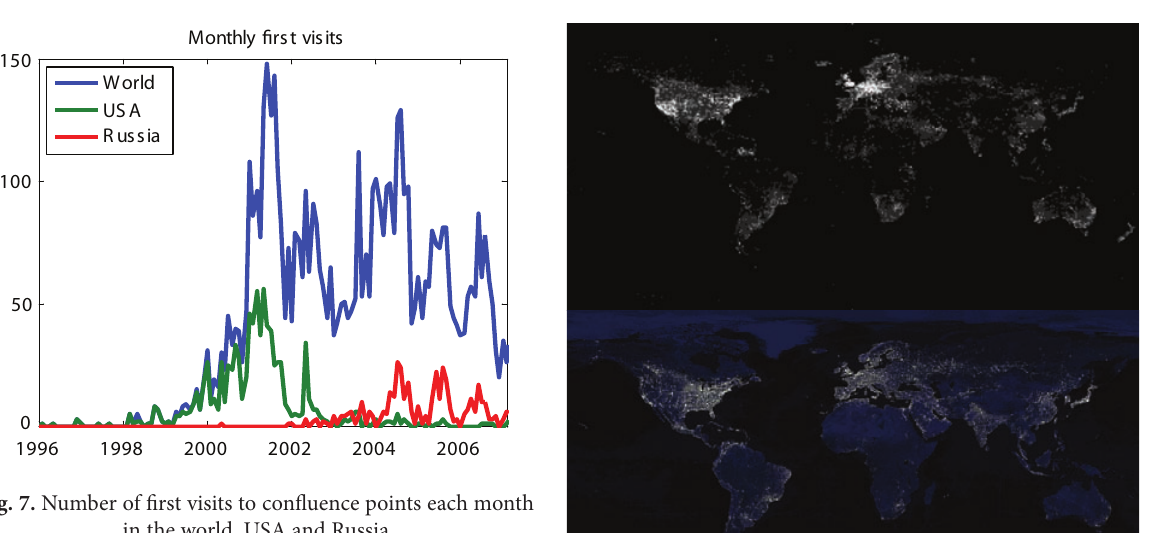
Fig. 7. Number of first visits to confluence points each month